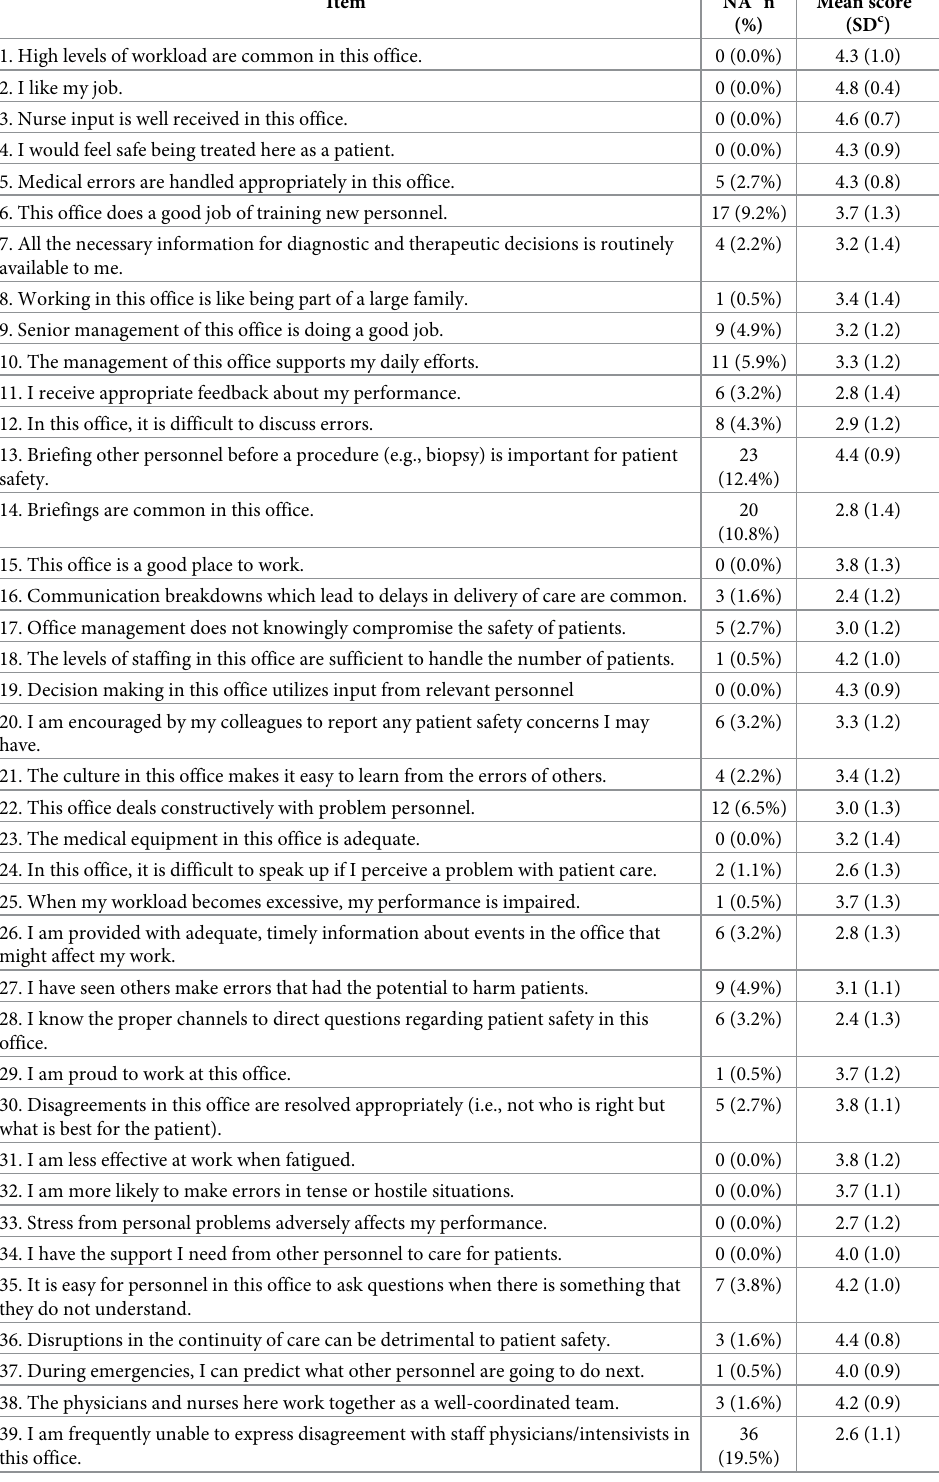
Table 1. Descriptive statistics for 62 items of the SAQ-AV questionnaire (185 respondents from 29 health care centres in Croatia providing out-of-hours